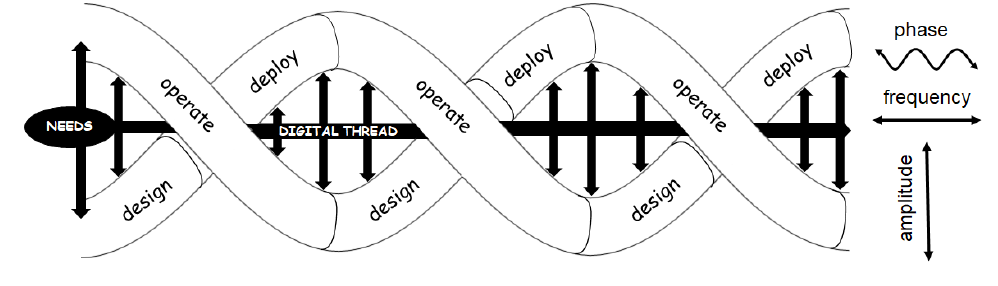
Figure 4. Double Helix model [74].